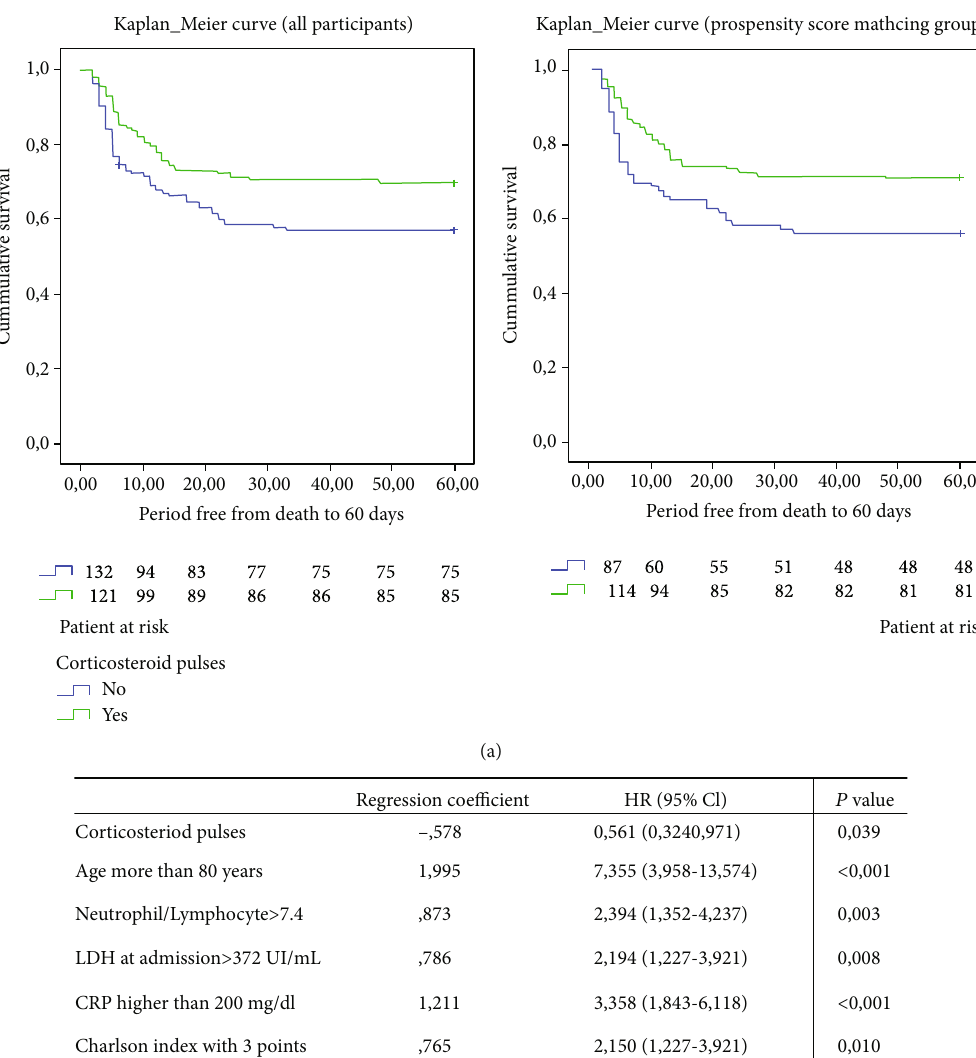
Figure 3: (a) Kaplan-Meier estimates of 60-day mortality in patients with and without corticosteroid treatment. (b) Cox regression for evaluating the 60-day mortality in the matched